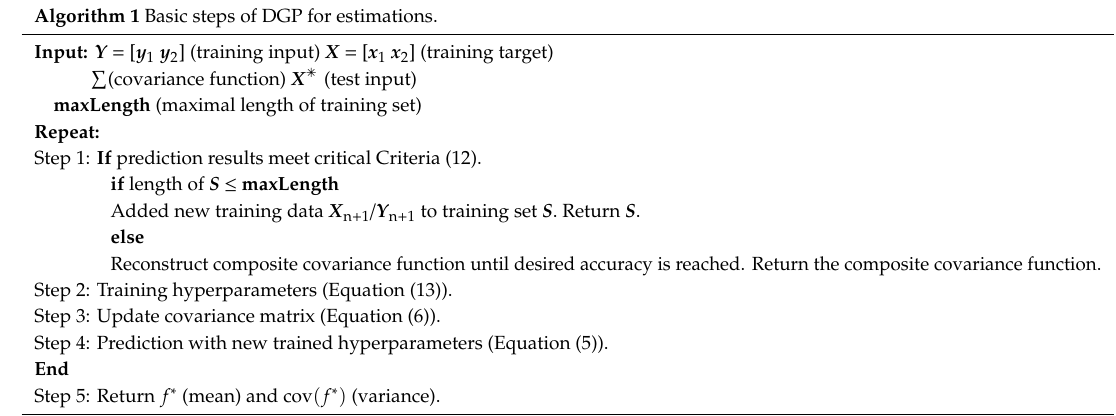
Algorithm 1 Basic steps of DGP for estimations.